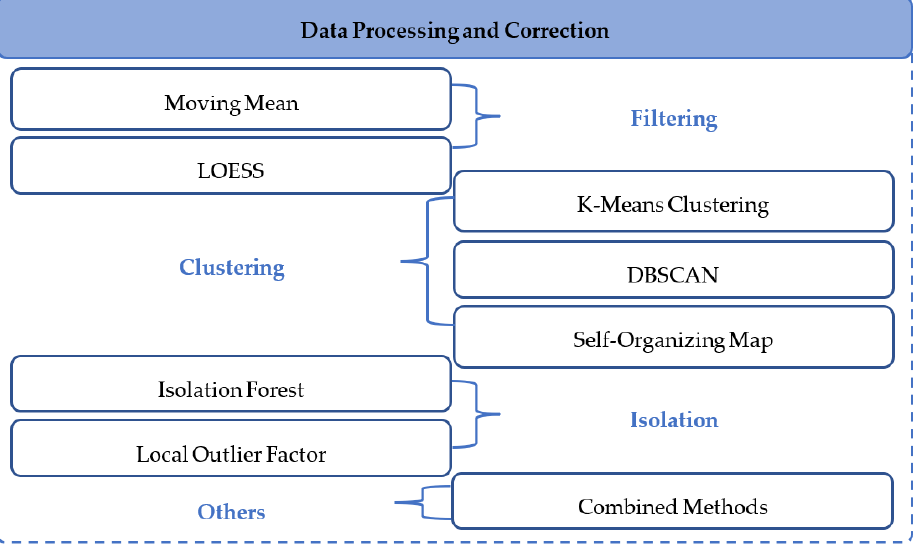
Figure 13. Reviewed data preprocessing and correction schemes.